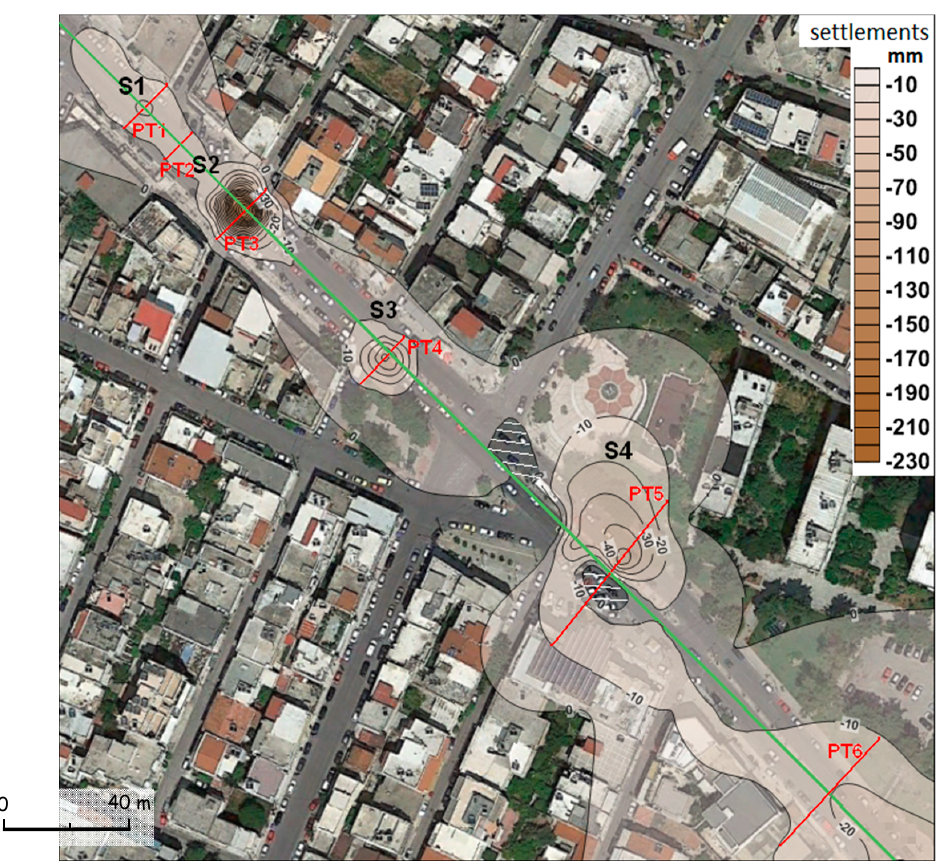
Figure 7. Settlement contours during the excavation of the Athens Metro Line 2 in the Panagi Tsaldari Avenue area superimposed on Google Map background. High subsidence contours are shown by increased color grading. White dashes indicate areas in which monitoring benchnmarks were destroyed and replaced, and observations were discarded because they record only part of the ground deformation. Asymmetries in the subsidence trough (ground loss) related to the distribution of buildings and greenfield areas suggest that observations on buildings underestimate subsidence due to sSSI. For significant results, only settlements above 10 mm are examined in this article.